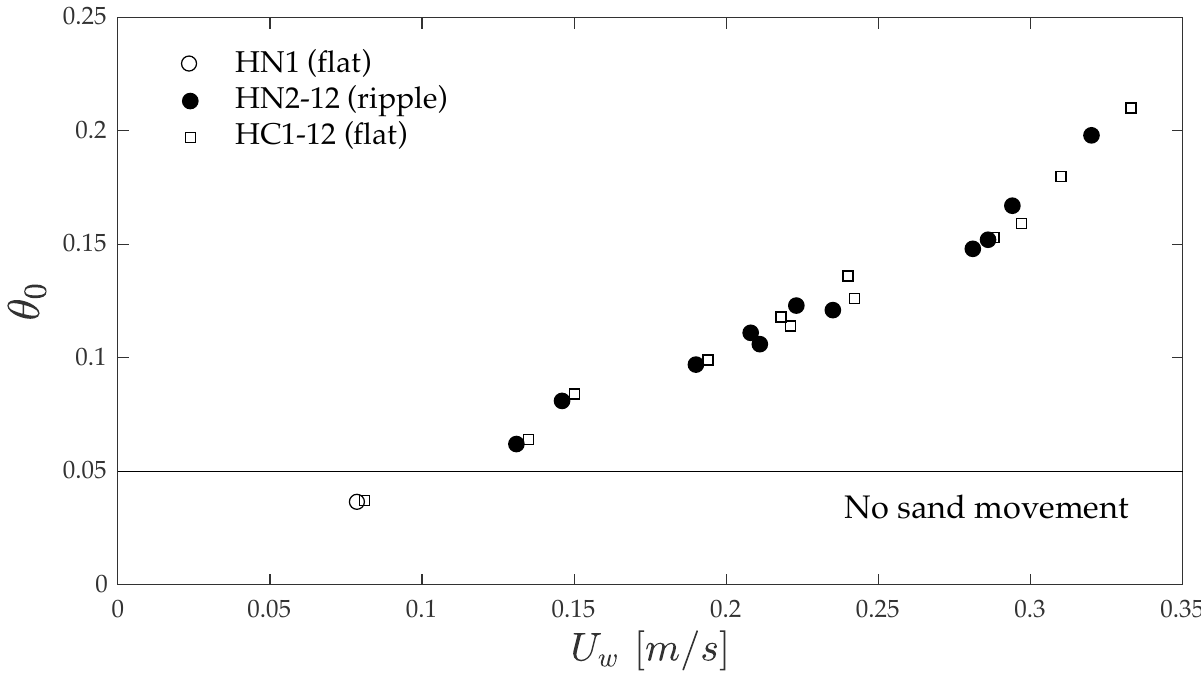
Figure 6. θ 0 for HN and HC test groups as a function of U w